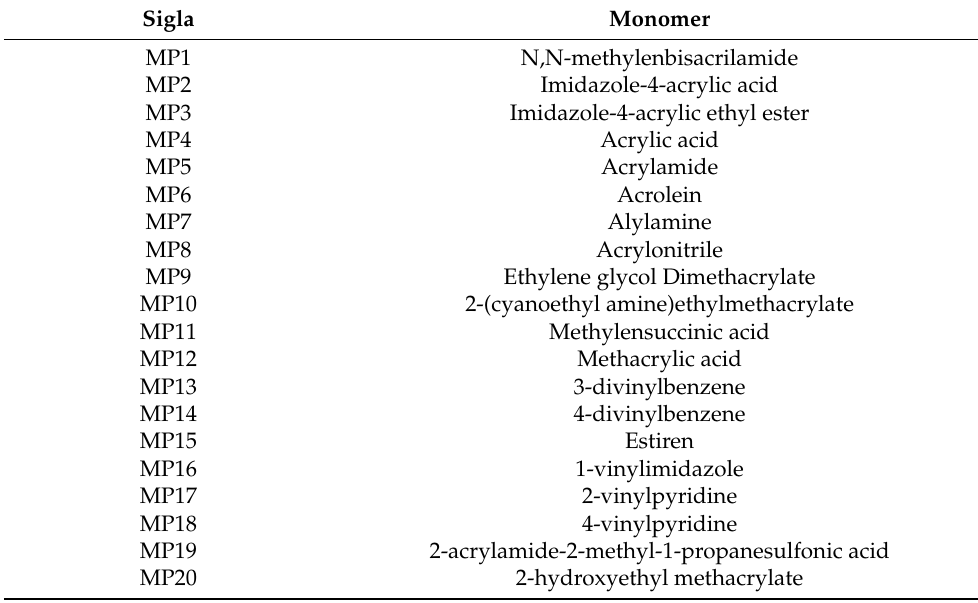
Table 1. Monomers used in the computational simulation analyses for the most stable interaction between AMX and